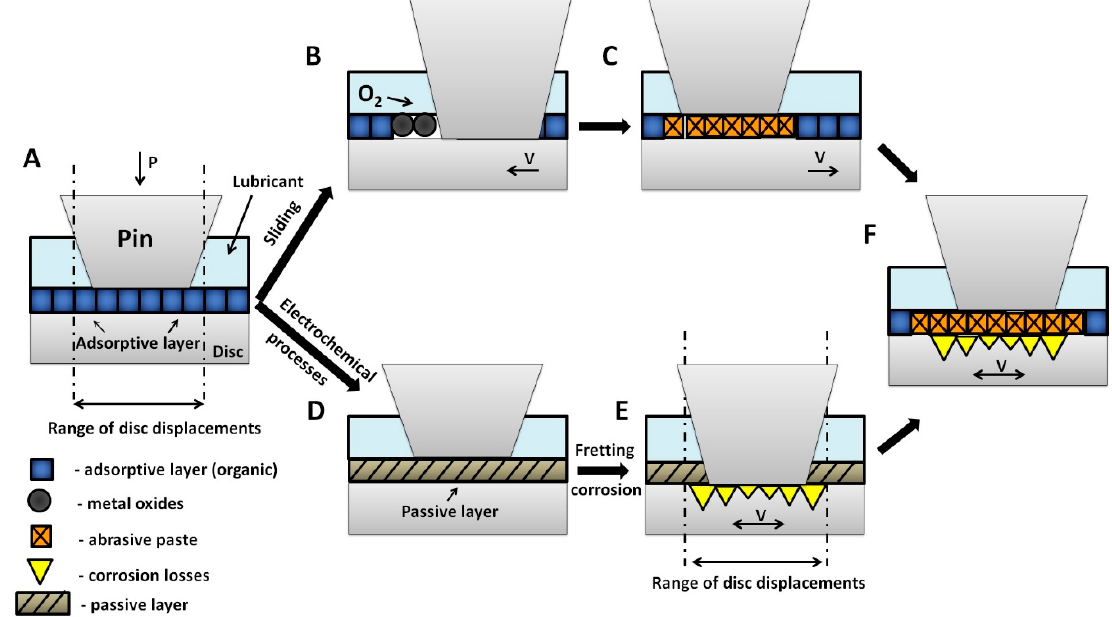
Figure 14. Phenomenological model of fretting corrosion processes: ( A )—destruction of adsorptive layer, chemical oxidation, ( B )—oxides accumulation, ( C )—abrasive paste formation, ( D )—passive layer, ( E )—fretting corrosion (intensification of corrosion processes), ( F )—tribological and corrosive wear.